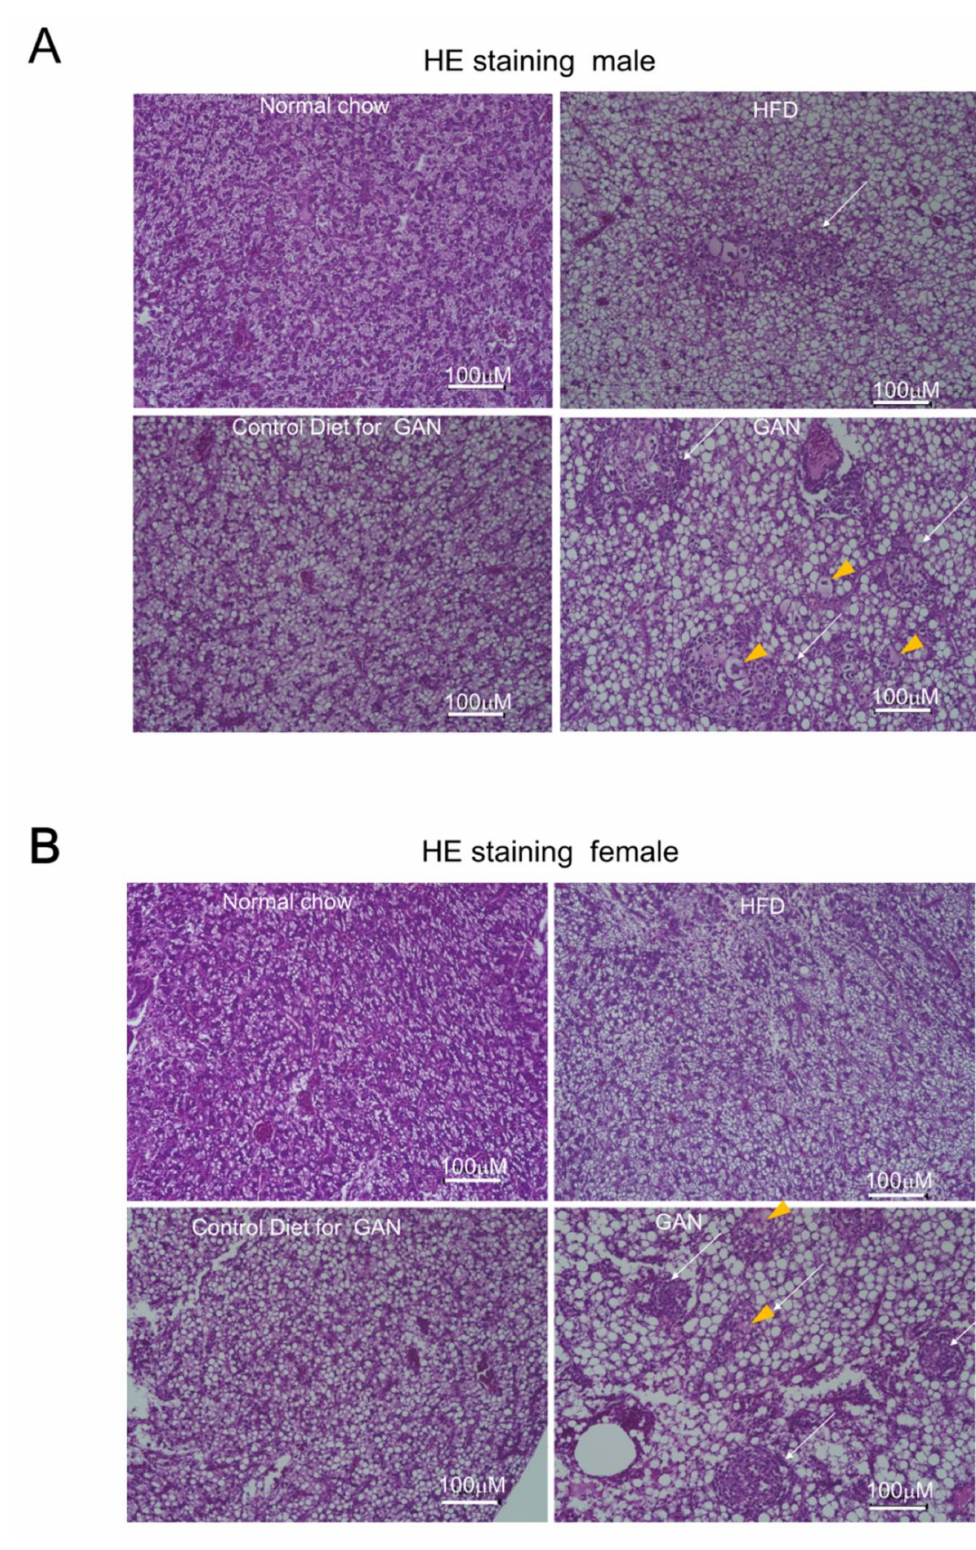
Figure 4. Evaluation of microscopic changes in the liver using hematoxylin and eosin (HE) staining. ( A ) male, ( B ) female. The arrowhead indicates ballooning cells; the arrow represents inflammatory infiltration; the white scale bar represents 100 µ